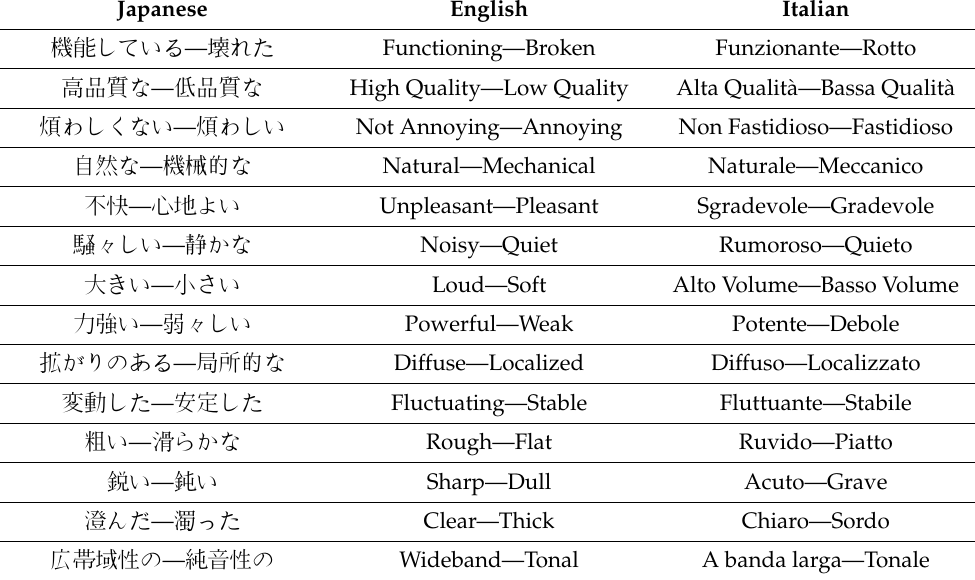
Table 1. Semantic Differential